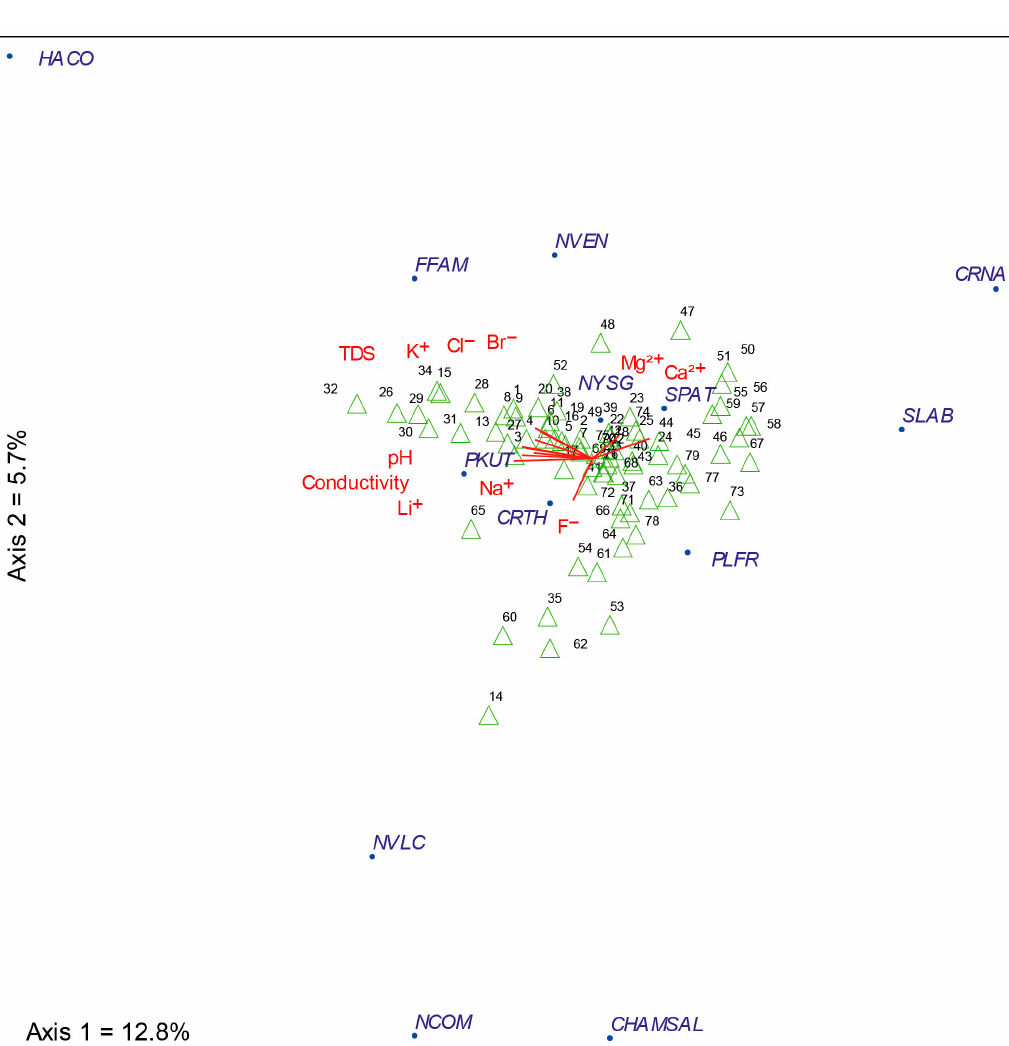
Figure 10. Canonical Correspondence Analysis (CCA) diagram showing the ordination of diatom species (in blue) and sampling site (i.e., springs, green triangles) along the first two axes and their correlation with environmental variables (in red). The spring numbers are presented in Table S1.